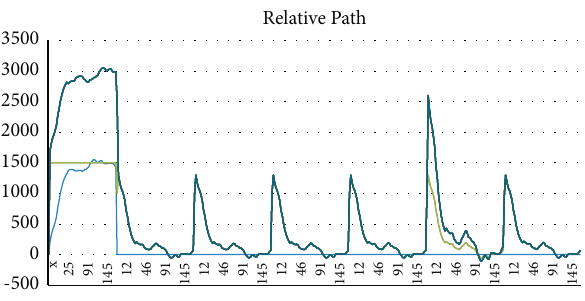
Figure 5: Work under 15 different wavelengths and 155 different angles [4].